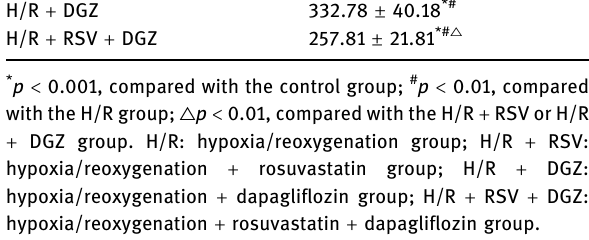
Table 2: Comparison of the activity of LDH in the fi ve groups ( mean ± SD, n = 6 ) Group